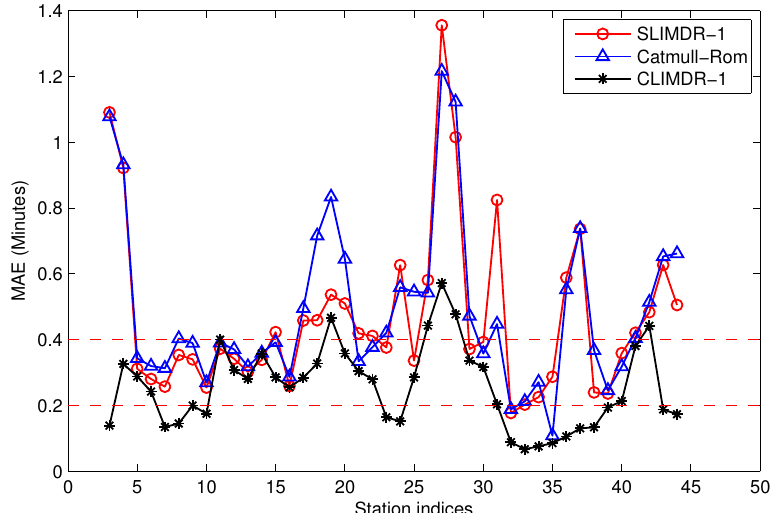
Figure 19. Comparisons of the MAE performances of the recovered data by contextual linear interpolation for missing data recovery